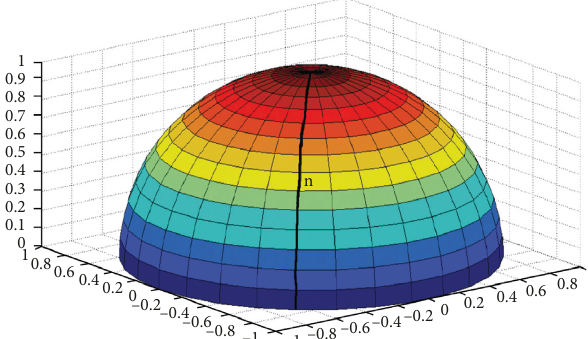
Figure 6: The largest curvature n selected on the hemisphere.